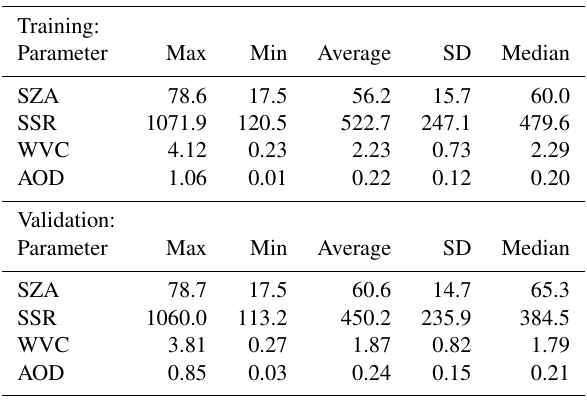
Table A1. The statistics between the training and the validation data for the input and the output parameters. The units for SZA, SSR and WVC are degrees, Wm − 2 and centimetres respectively.